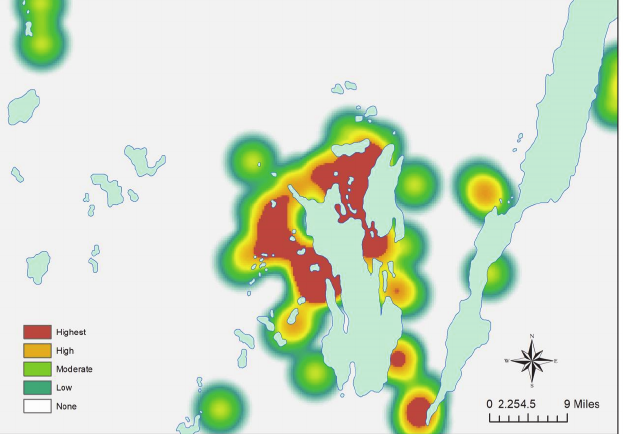
Fig. 2. Heatmap fishing ground in Kei islands for Artisanal